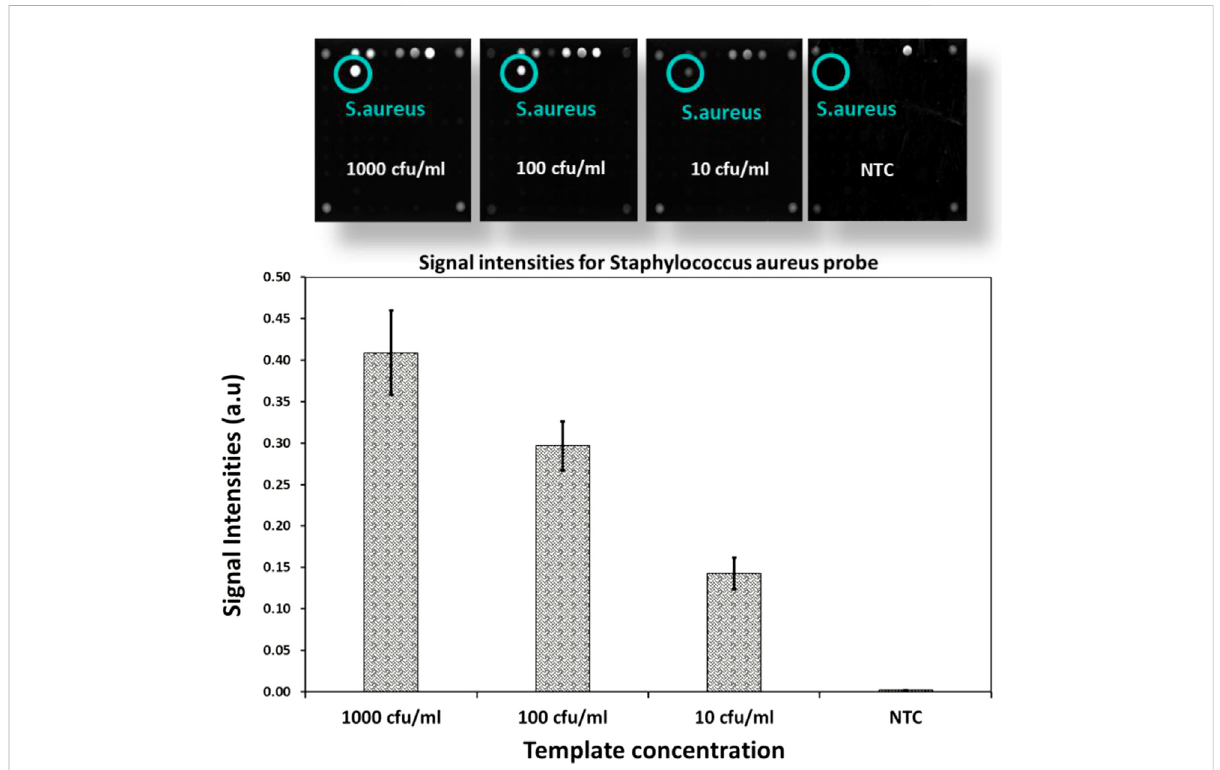
FIGURE 7 LOD ofAELA PCR and Microarray system: Microarray imagesand bar chart with signal intensities obtained after the hybridization ofthe dilution series of spiked Staphylococcus aureus sample (NTC represents No Template Control). Microarray image shows signal intensities for different controls used in the assay (not discussed in this manuscript) and Staphylococcus aureus probe. The Staphylococcus aureus probe is circled in green and annotated at each concentration.